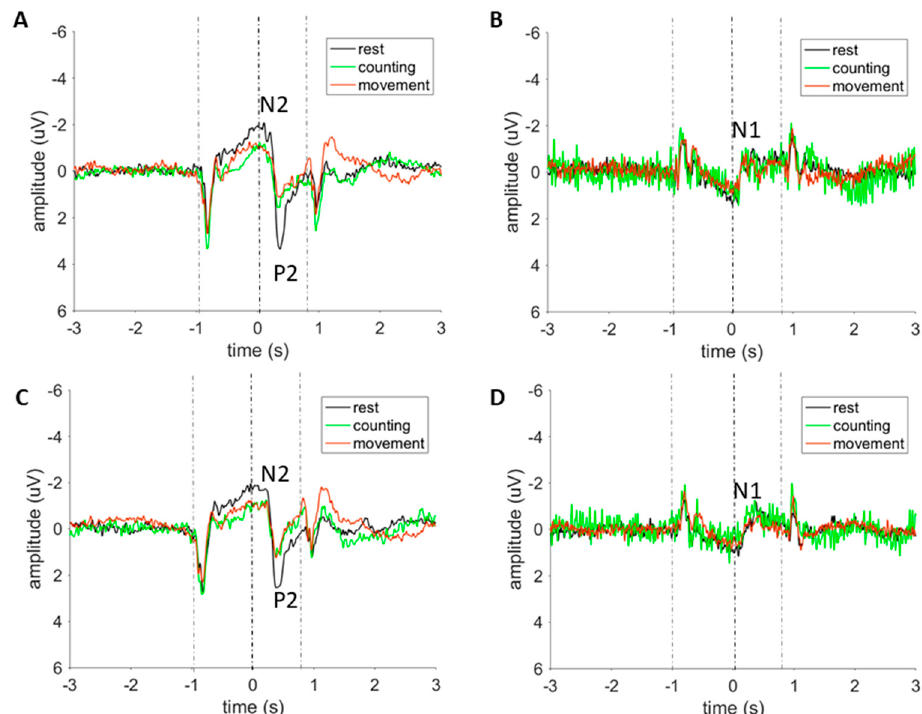
Figure 3. Group-level laser evoked potentials in the time domain, separated by condition. The two gray dotted lines are representing the onset of the visual stimulus. The black dotted line is representing the onset of the laser stimulus. The peaks of the laser-evoked potentials (LEP) are indicated on the figure. ( A ): Average waveforms at Cz (vs. average reference) for hand stimulation. ( B ): Average waveform at T8 (vs. Fz) for hand stimulation. ( C ): Average waveforms at Cz (vs. average reference) for foot stimulation. ( D ): Average waveforms at T8 (vs. Fz) for foot stimulation.